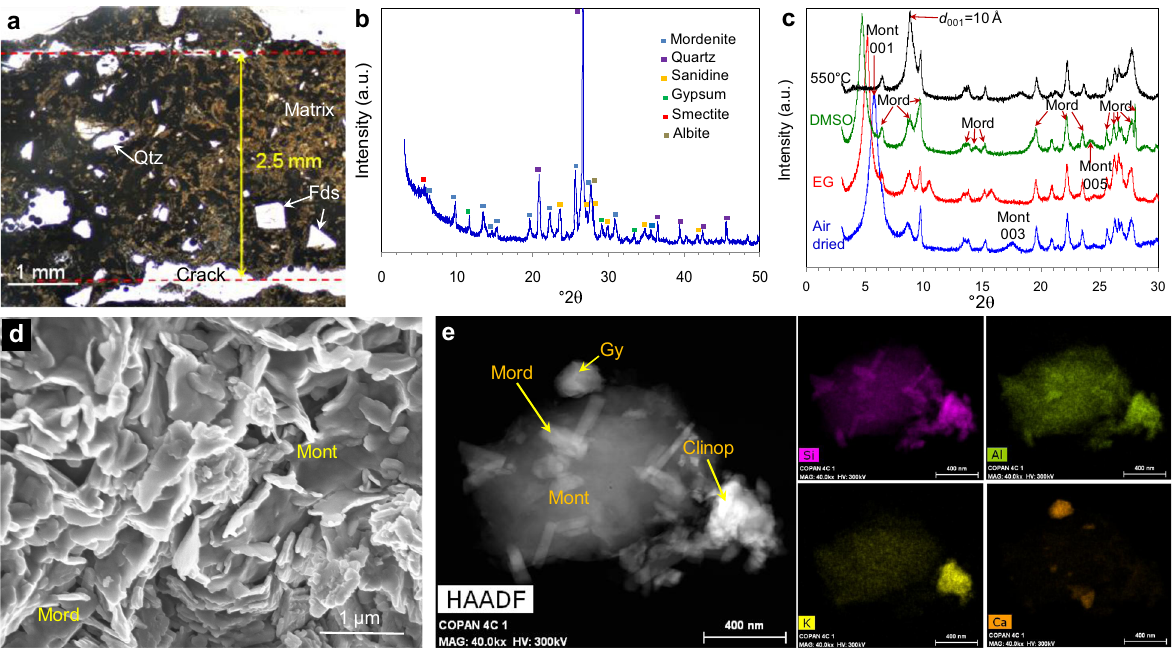
Fig. 2 Texture and mineralogy of Copan stone. a Optical microscopy image of the partially devitri fi ed glass matrix with scattered quartz (Qtz) and feldspar (Fds) phenocrystals (plane light). Note the development of fractures parallel to the stone surface (upper part) with separation of ~2.5 mm. b XRD pattern of representative greenish-colored tuff stone (Copan 3). c XRD pattern of oriented aggregates of the clay fraction. Note the shifting to lower 2 θ angles after solvation with EG and DMSO, and the collapse of the montmorillonite (Mont) main Bragg peak from d 001 = 14.9 Å to d 001 = 10 Å after heat treatment. Note also that mordenite (Mord) is an abundant phase in the fraction < 2 µm. d FESEM image of montmorillonite ( fl ake-like) particles along with mordenite (prism-like) particles. e HAADF STEM image and corresponding elemental maps of the main phases present in the devitri fi ed matrix of the most abundant buff or greenish colored tuff (Copan stone Type 2), made up of montmorillonite, mordenite, and clinoptilolite (Clinop), along with traces of gypsum